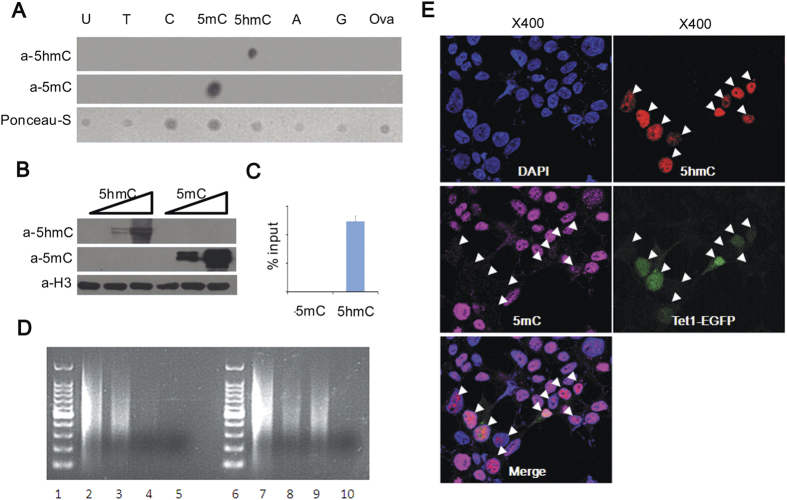
Identification of the specificity of anti-5hmC antibody.(A) Dotblot analysis. Equal conjugated bases were loaded and immunnoblotted with an antibody against 5hmC (top) or 5mC (middle). Loading was shown by Ponceau staining (bottom). (B) Western blotting. 0, 5, 50 pg of nucleoside-conjugated-ovalbumin was mixed with 293T cell lysate and separated by SDS-PAGE and immunnoblotted with anti-5hmC (upper), anti-5mC (middle) and anti-H3 antibodies (bottom). (C) qPCR quantifying immunoprecipitated DNA fragments containing 5mC or 5hmC by the anti-5mC (left) or anti-5hmC (right) antibody. (D) Denatured fragmented DNA from Tet1 nontransfected (Lane 2–5) or transfected (Lane 7–10) 293T cells was immunoprecipitated by an antibody for 5mC (lanes 3 and 8), 5hmC (Lanes 4 and 9), or control IgG (Lanes 5 and 10). Lanes 1 and 6 are 100-bp DNA marker and lanes 2 and 7 have 10% of DNA input. (E) Immunofluorescence analysis. 293T cells transfected with cDNA encoding the Tet1 catalytic domain-IRES-GFP (middle right, arrowheads) were stained with DAPI (top left), anti-5hmC antibody (top right), or anti-5mC antibody (middle left). Merged Image was in bottom left.